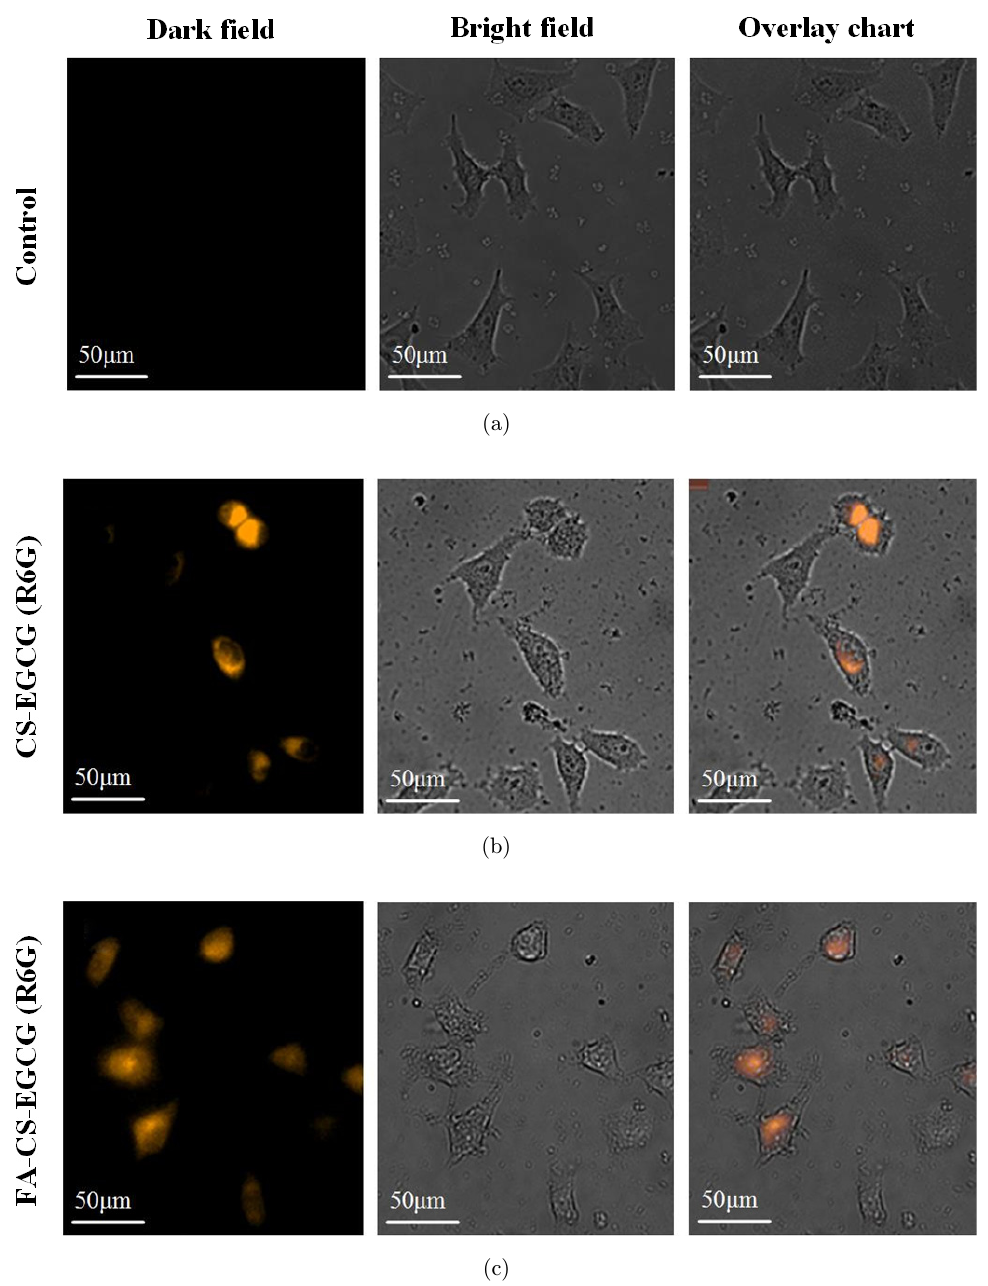
Fig. 6. Inversed °uorescent microscope images of MCF-7 cell culture treated with (a) Control, (b) CS-EGCG and (c) FA-